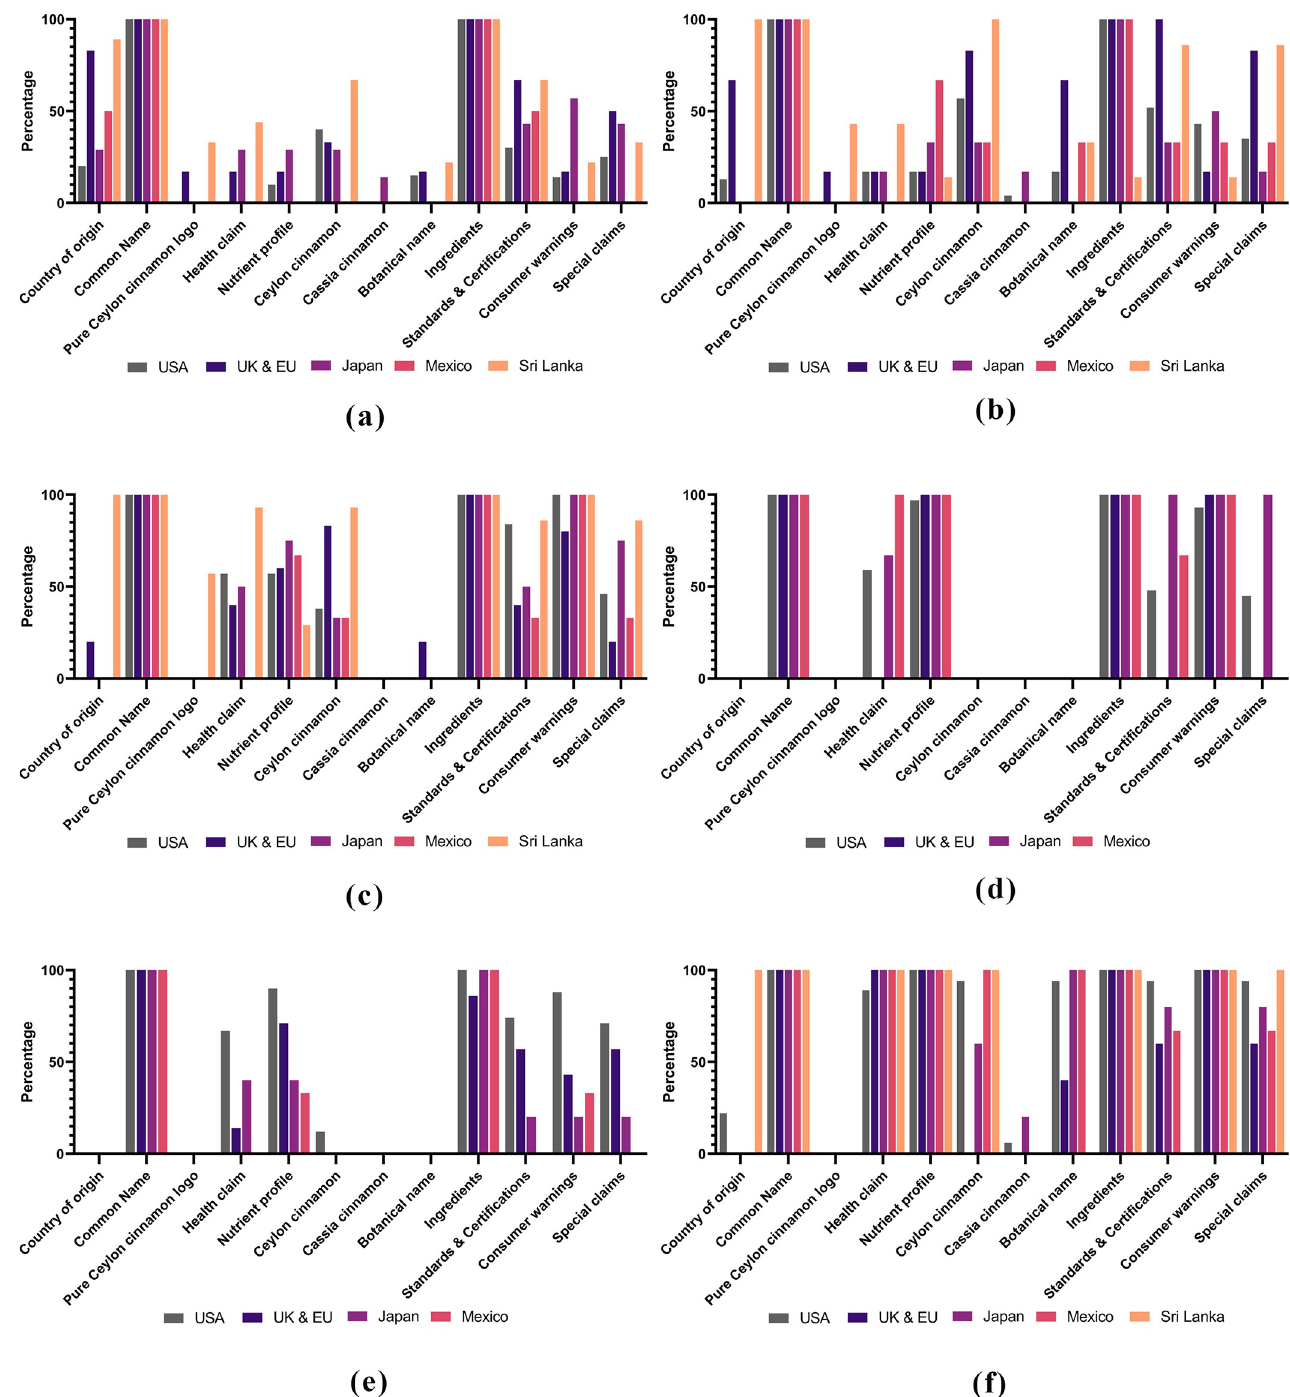
Fig 5. Cinnamon label claims in deferent markets. (a) Label claims of the cinnamon quills available in the main markets. Null hypothesis was rejected (Decision rule p � 0.05); there was a significant association between markets and label claims of cinnamon quills. Common name, pure Ceylon cinnamon logo, health claims, nutrient profile, cassia cinnamon, botanical name, and ingredients showed significant relationship. Label attributes; Country of origin (p = 0.465), Common Name (p = 0.025), Pure Ceylon cinnamon logo (p = 0.039), Health claim (p = 0.042), Nutrient profile (p = 0.042), Ceylon cinnamon (p = 0.176), Cassia cinnamon (p = 0.034), Botanical name (p = 0.042), Ingredients (p = 0.025), Standards & Certifications (p = 1.000), Consumer warnings (p = 0.080), and Special claims (p = 0.068) were considered for the hypothesis testing. (b) Label claims of the cinnamon powder available in the main markets. Null hypothesis was rejected (Decision rule p � 0.05); there was a significant association between markets and label claims of cinnamon powder. Common name, pure